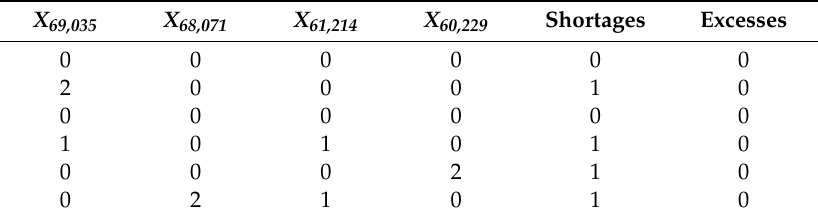
Table 5. Non-integer decision variables.